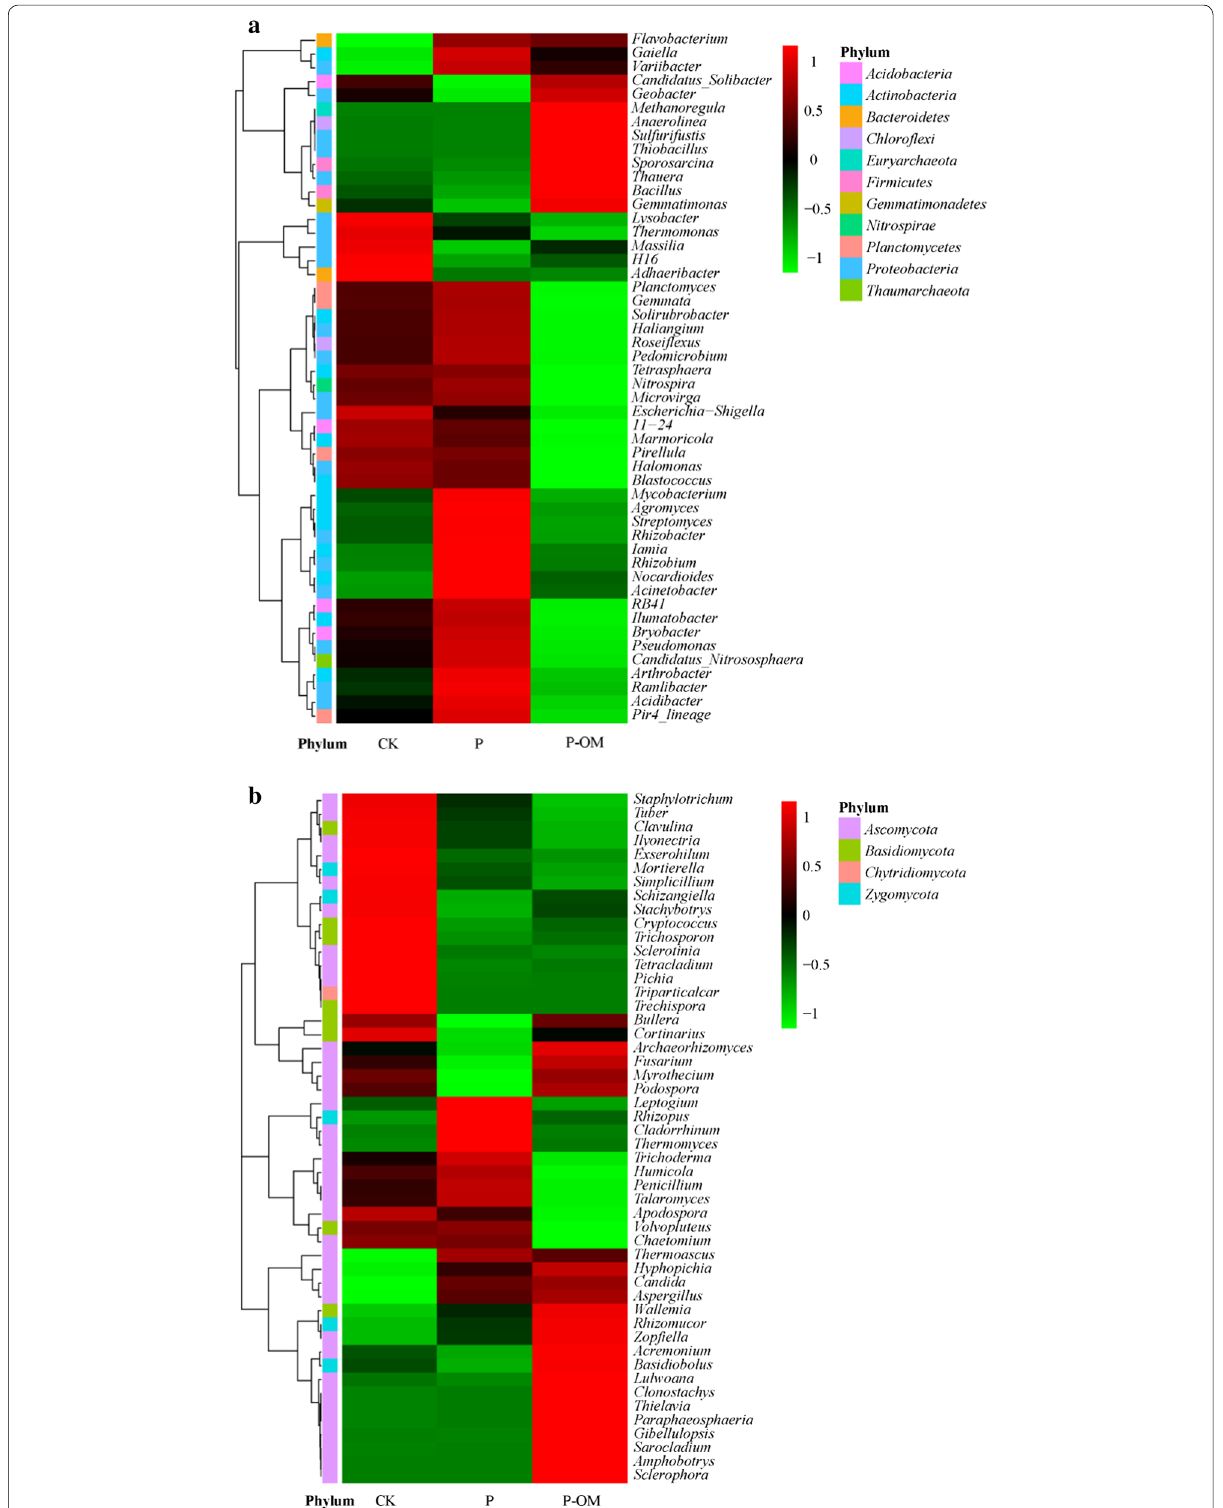
Fig. 4 Hierarchically clustered heatmaps based on the top 50 genera of bacterial ( a ) and archaeal ( b ) composition. The relative abundance for each genus was depicted by color intensity with the legend. The genera relative abundances are the average of the triplicate Miseq sequencing